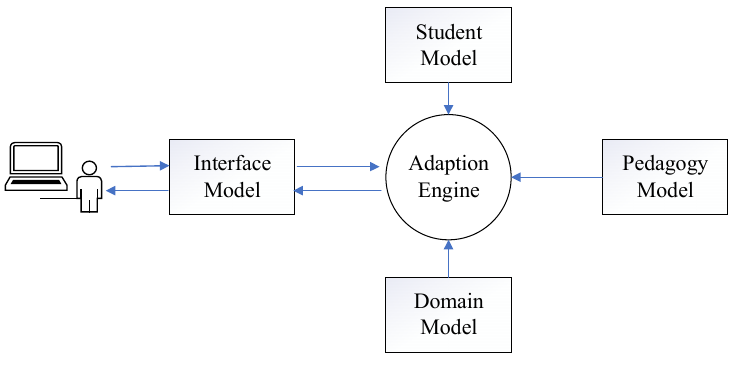
Figure 6. AEHS Model.